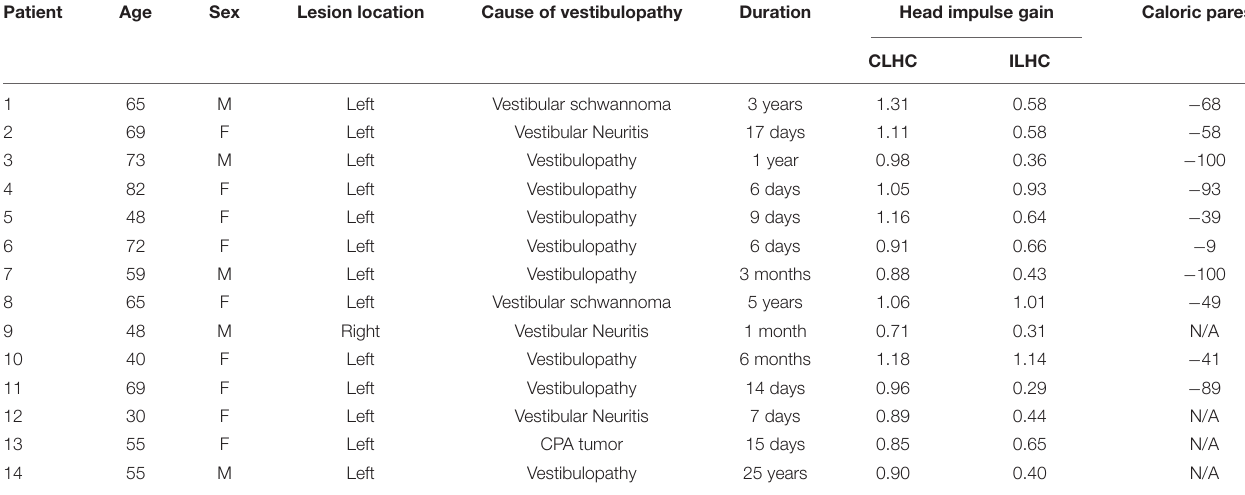
TABLE 1 | Clinical characteristics of included patients.